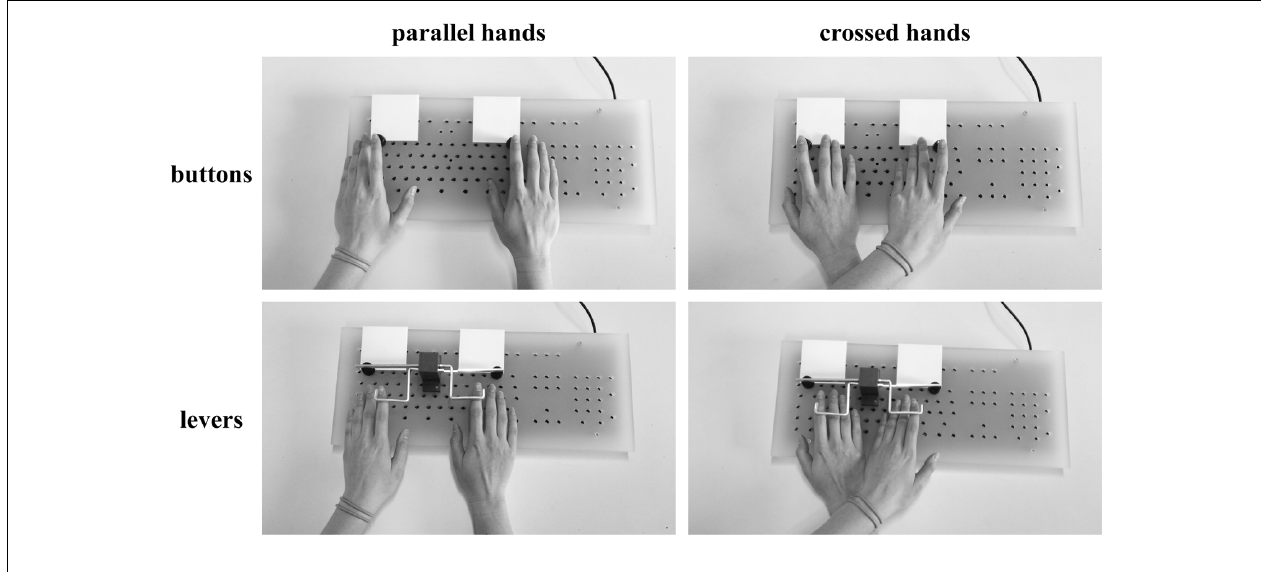
relevance for the hemispheric allocation of response monitoring processes cannot be determined. In contrast, the levers provide the necessary dissociation because the physical effector (button) is now located in a different hemifield than the physiological effector (hand). For mechanical reasons, buttons had to be pressed while levers had to be